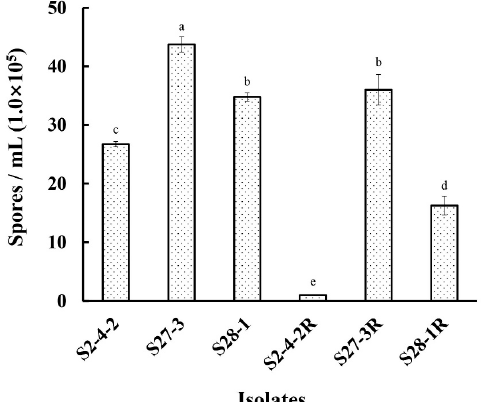
Figure 2. Sporulation of three pydiflumetofen mutants of F. graminearum. The sporulation of the resistant mutants (R) and their wild-type parental isolates was assessed after 3 day’s incubation in MBB at 24 °C with shaking (130 rpm). Data are the means of three replicates ± standard error (SE). Different lowercase letters above the columns indicate significant differences ( p ≤ 0.05) according to Fisher’s least significant difference test ( p ≤ 0.05).